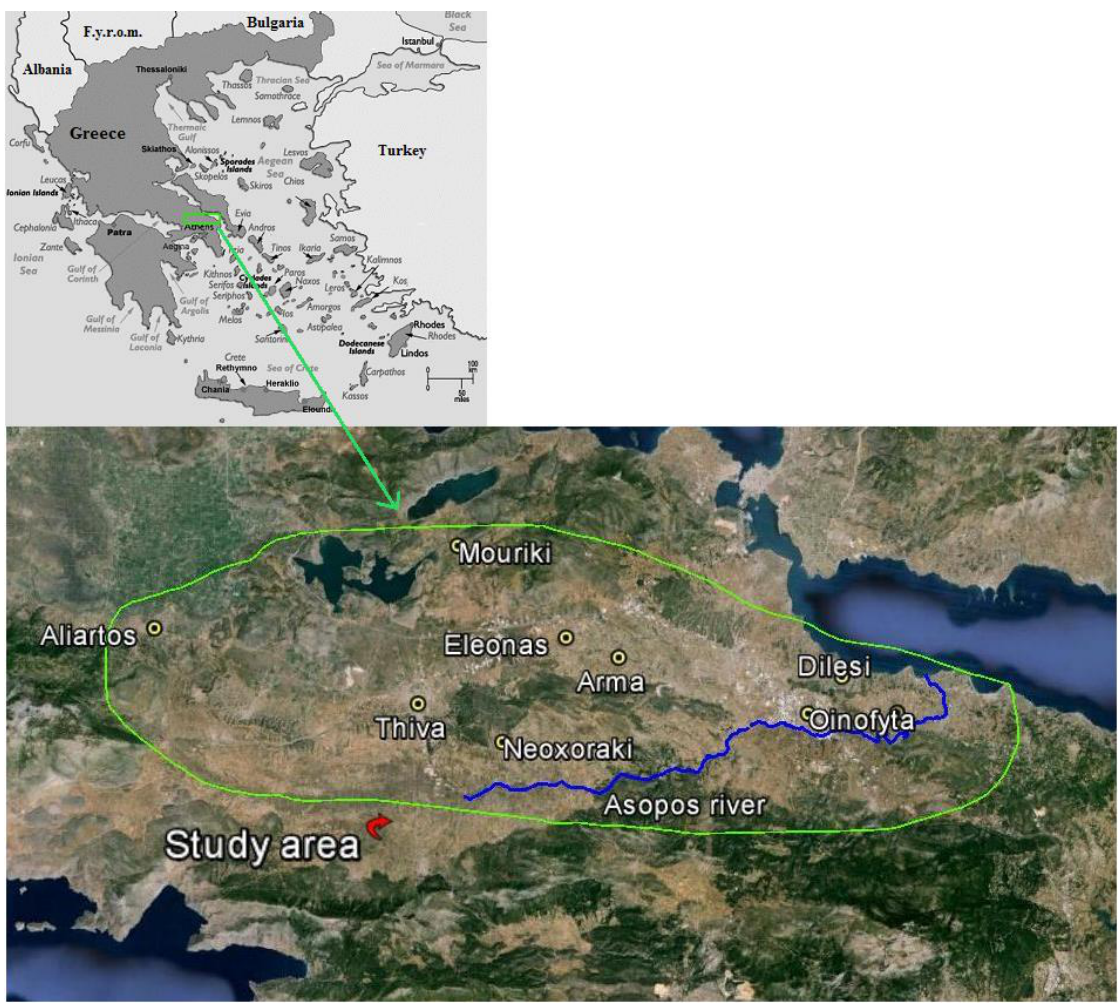
Figure 1. Map of the study